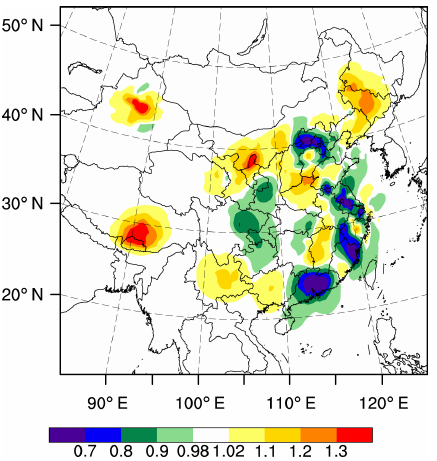
Figure 7. Spatial distribution of λ PM averaged over all hours from 6 to 16 October